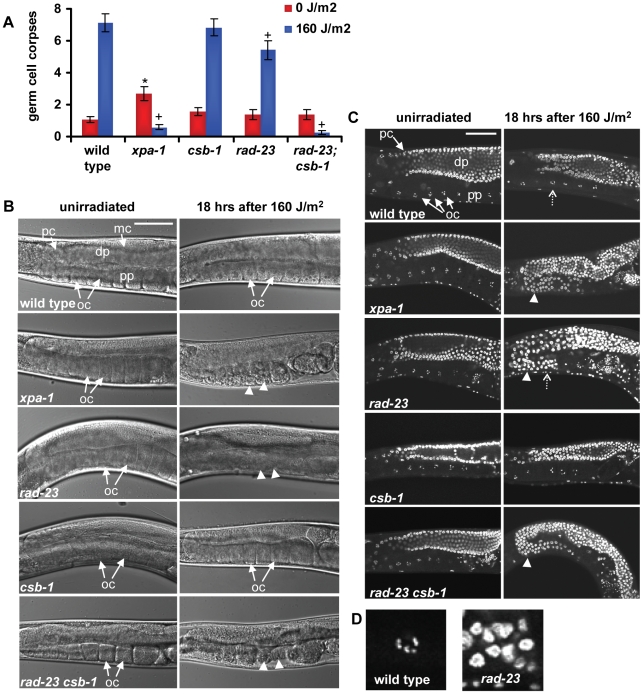
Germ cell responses to UVB irradiation.(A) Amount of apoptotic cells 6 hours following no or 160 J/m2 UVB irradiation is shown. Each bar represents two independent experiments. Error bars denote s.e.m. Significant differences (p<0.05) compared to wild type (*) and 160 J/m2 irradiated wild type (+) are indicated. (B) Nomarski images of unirradiated and irradiated gonads, 18 hrs after 160 J/m2 UVB. In xpa-1, rad-23, and rad-23; csb-1 mutants, the appearance of the proximal gonad part drastically changes over time after irradiation. In the first image, mitotic cells (mc), pachytene cells (pc), oocytes (oc, arrows), the distal part (dp) and the proximal part (pp) of the gonad are indicated. Arrowheads indicate morphological changes in oocytes after UV. Bar in first image represents 50 µm. (C) Germ cells of animals 18 hrs after no or 160 J/m2 UVB irradiation, fixed and stained with DAPI. In irradiated xpa-1, rad-23 and rad-23; csb-1 animals, pachytene like germ cells progress beyond the gonad bend (indicated by arrowheads) in contrast to wild type and csb-1 animals. In the first image, pachytene cells (pc), diakinesis oocytes (oc, arrows), the distal part (dp) and the proximal part (pp) of the gonad are indicated. Typical oocytes are easily distinguishable due to their condensed homologous chromosomes pairs. Bar in first image represents 50 µm. The areas indicated by the dashed open arrows for irradiated wild type and rad-23 are enlarged in (D).